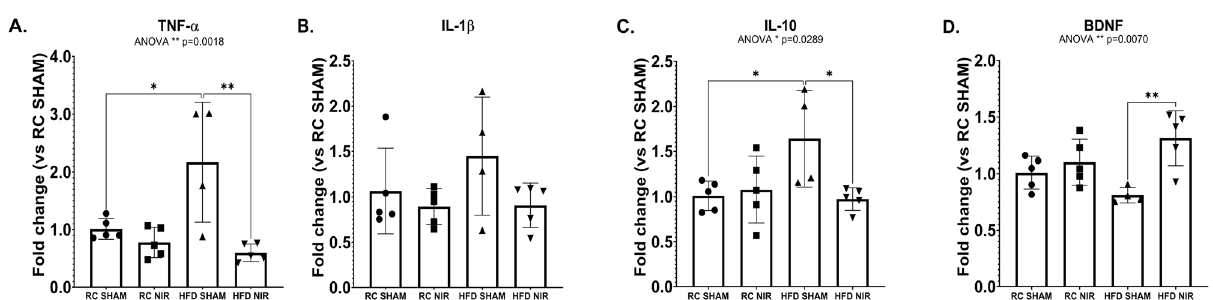
Figure 7. q-RT-PCR analyses of hippocampal cytokine and BDNF levels in RC- and HFD-fed mice with or without NIR. The two pro-inflammatory cytokines, TNF-α ( A ) and IL-1β ( B ), were upregulated after HFD, compared to control mice (the increase in IL-1β was not significant). NIR reduced TNF-α and IL-1β levels. The anti-inflammatory cytokine IL-10 ( C) showed the same increasing trend as TNF-α and IL-1β. n = 4–5 animals/ group; 2 replicates/animal; 2 technical replicates. Data are presented as mean ± SD. Statistical analyses: one- way ANOVA with Tukey’s post-hoc test. * p < 0.05, ** p < 0.01. ( D ) Hippocampal BDNF was downregulated in HFD SHAM versus RC mice, but the decrease was not significant. NIR induced BDNF significant upregulation in HFD-fed mice, compared to untreated animals. Graphs were created with GraphPad Prism 8.4.3 and 9.3.1 software (https:// www. graph pad. com/). Images and graphs were composed in Adobe Photoshop 22.2.0 (https:// www. adobe. com/ produ cts/ photo shopf amily.